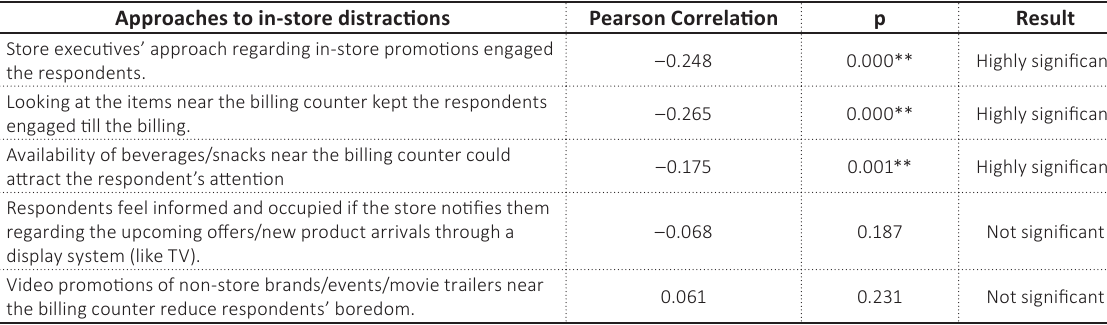
Table 5. Relationship between in-store distractions and emotional discomfort during the billing Approaches to in-store